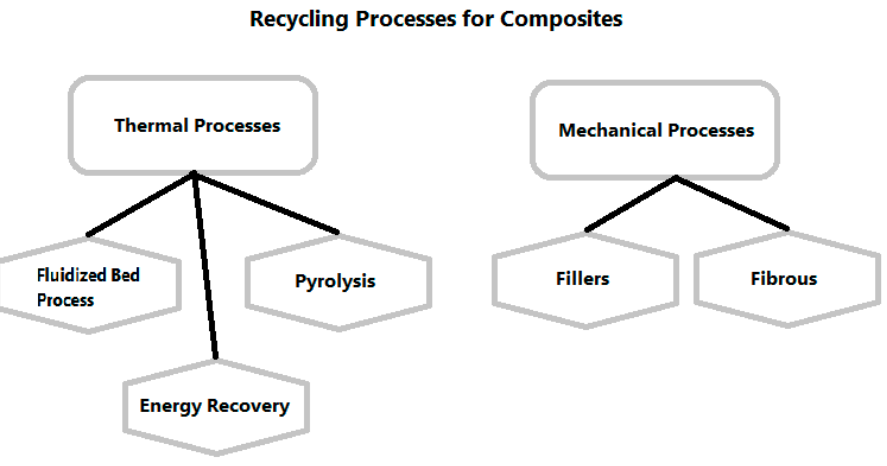
Figure 2. Recycling processes for composites.